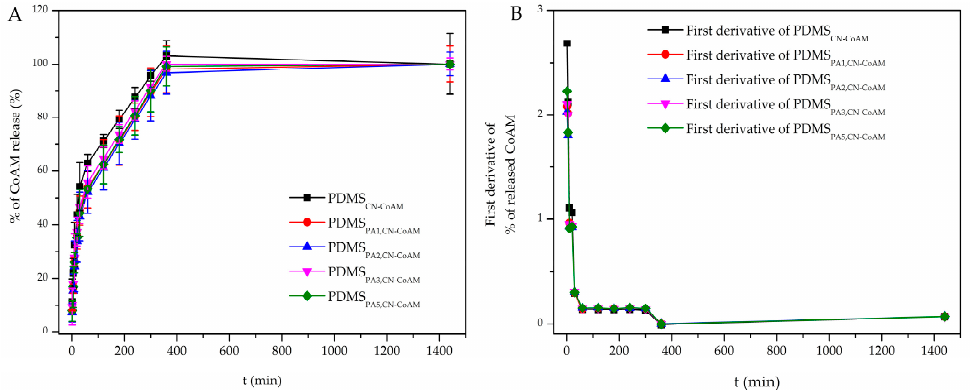
Figure 6. Time-dependent change in the percentage of the released incorporated drug.